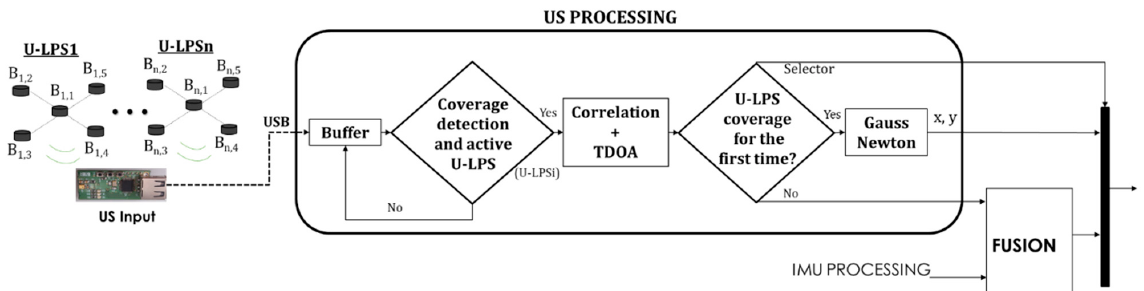
Figure 7. Block diagram of the US Processing tasks.